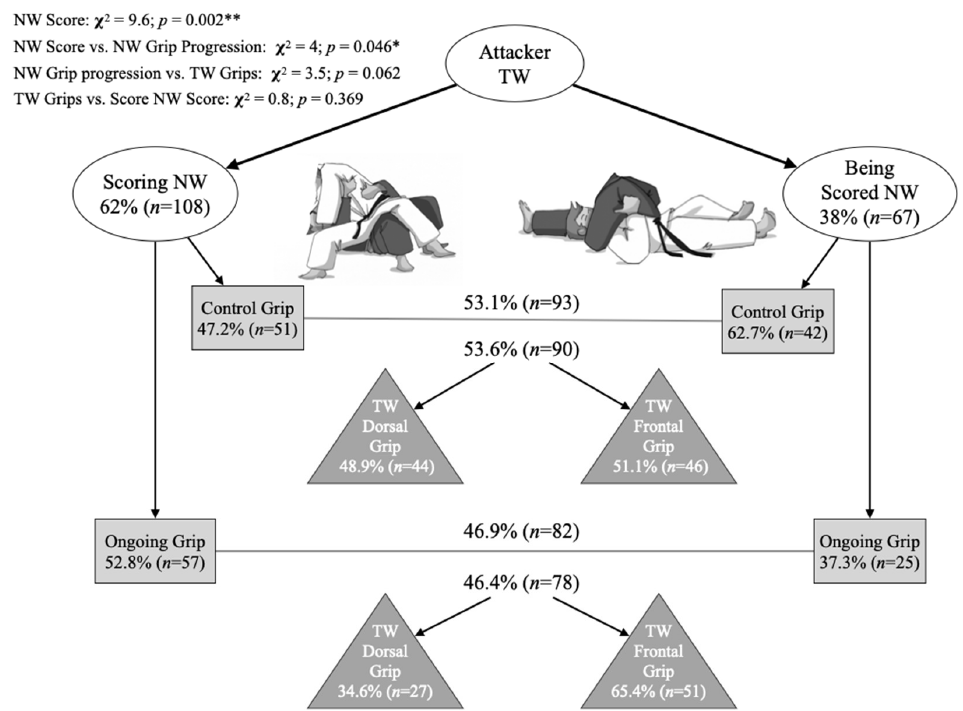
Figure 3. Associations between ne-waza (NW) score (circles), grip progression during NW (squares), and attacking grips during the preceding tachi-waza (TW) (triangles). Grip progression was categorized as control grip (when at least one hand was maintained from the TW attack to NW scoring action) and ongoing grip (both hands showed new grips from the TW attack to the NW scoring actions). Percentages above the grey lines represent the distribution of grip progression categories. Percentages below the line represent the distribution of grip progression categories when crossed with TW grips. Significant differences: * p < 0.05; ** p < 0.01.